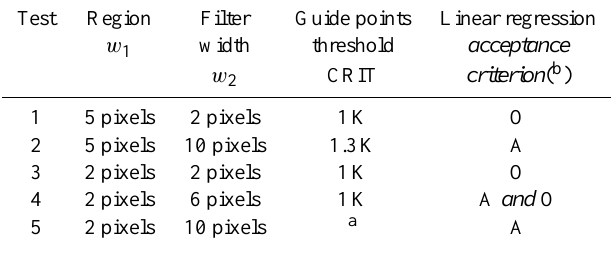
Table 2. Description of ACTA’s Step I tests. a Scene-dependent cri- terion, see explanation in text below (description of Test 5). b O: ori- entation, A: